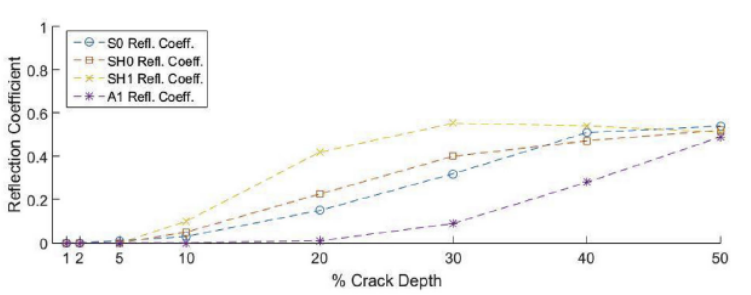
Figure 7. The predicted reflection coefficients of the S0, SH0, SH1 and A1 modes at varying crack depths on a 10 mm thick pipeline using the 2D finite element method. Reprinted under Creative Commons CC BY license [50].